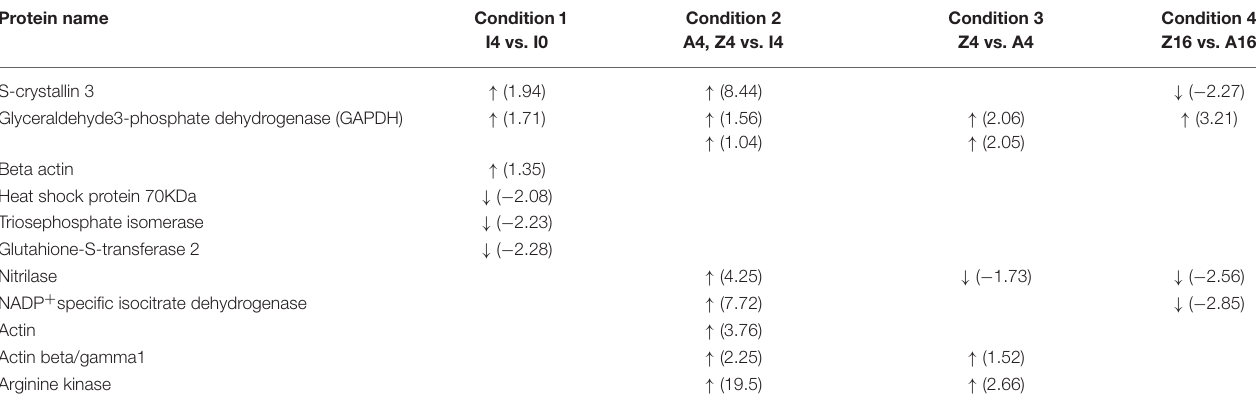
TABLE 2 | Summary of the fold changes in expression of protein identities differentially expressed in O. vulgaris paralarvae in the different condition studied as function of dietary group and